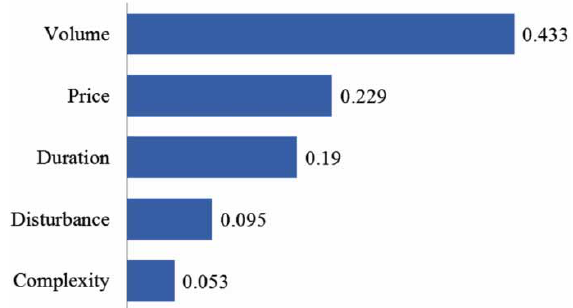
Fig. 6. Criteria significance with respect to goal